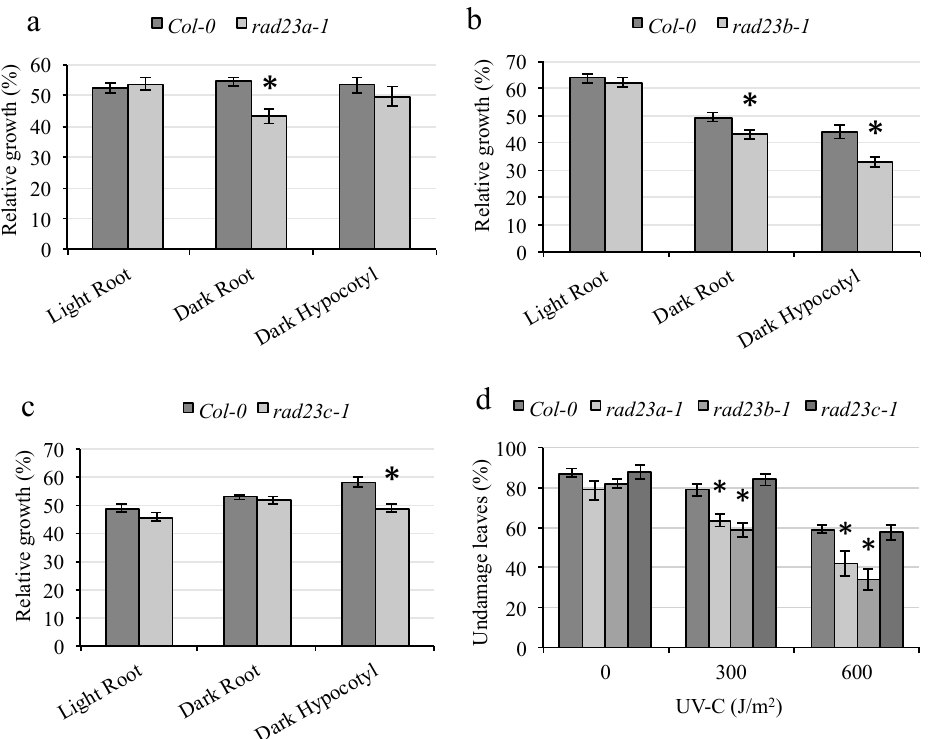
controls ( n = 20). ( b ) Root growth in light- and dark-incubated seedlings analyzed 2 days after UV treatment, expressed as relative to the untreated controls ( n = 20). The values are means ± SE, * = p < 0.05 for the mutant versus Col-0 wild type in the same conditions.